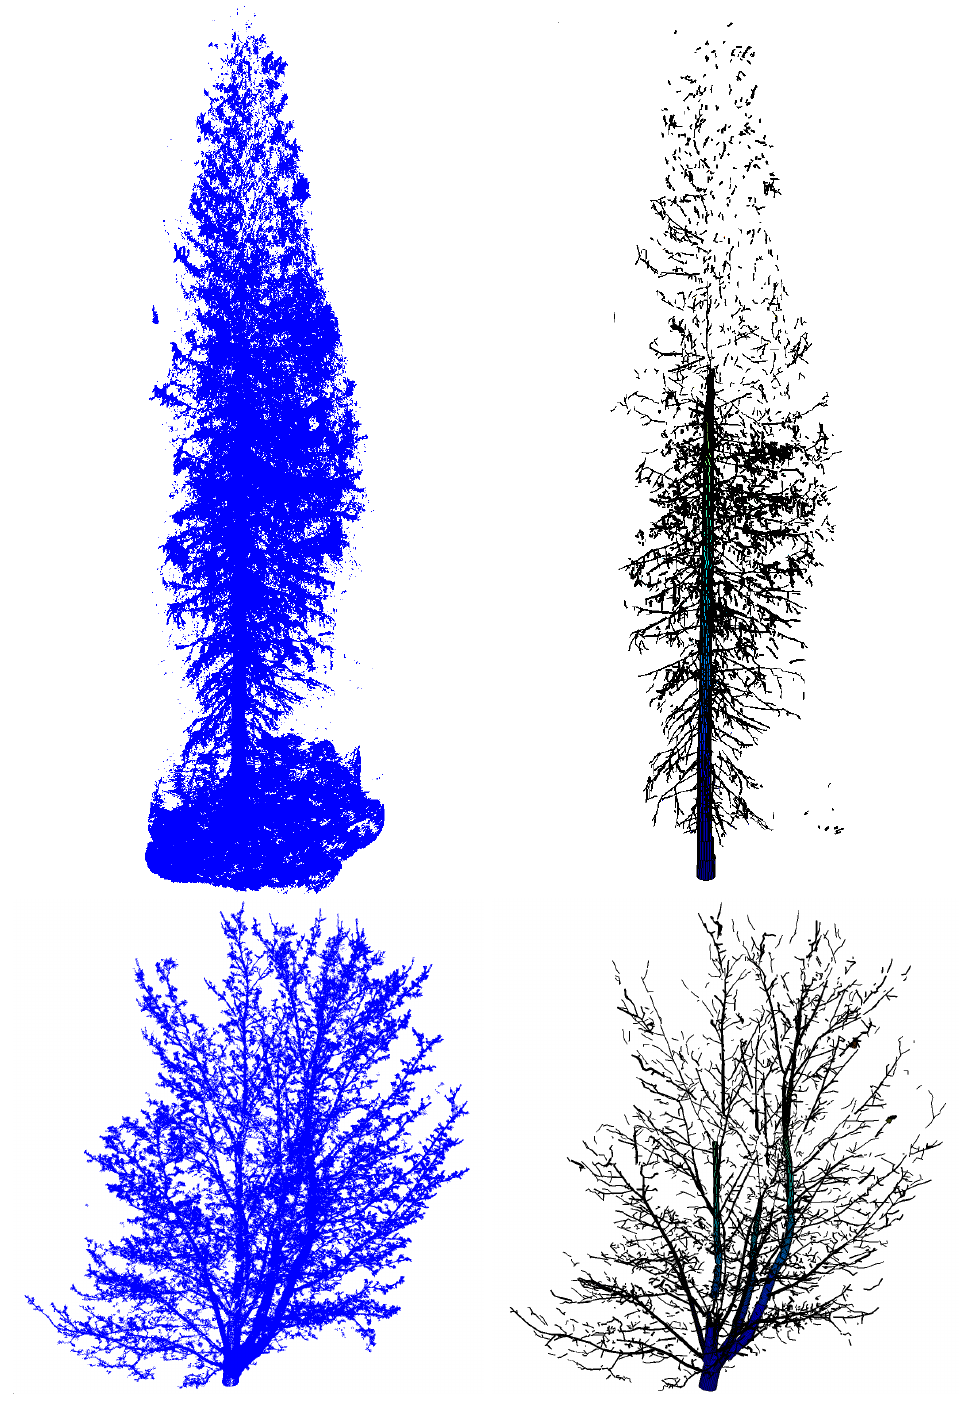
Figure 2. Point clouds and their final cylinder models. The point cloud ( top left ) and the cylinder model with some 7,070 cylinders ( top right ) of the spruce. The point cloud ( bottom left ) and the cylinder model with about 6,820 cylinders ( bottom right ) of the